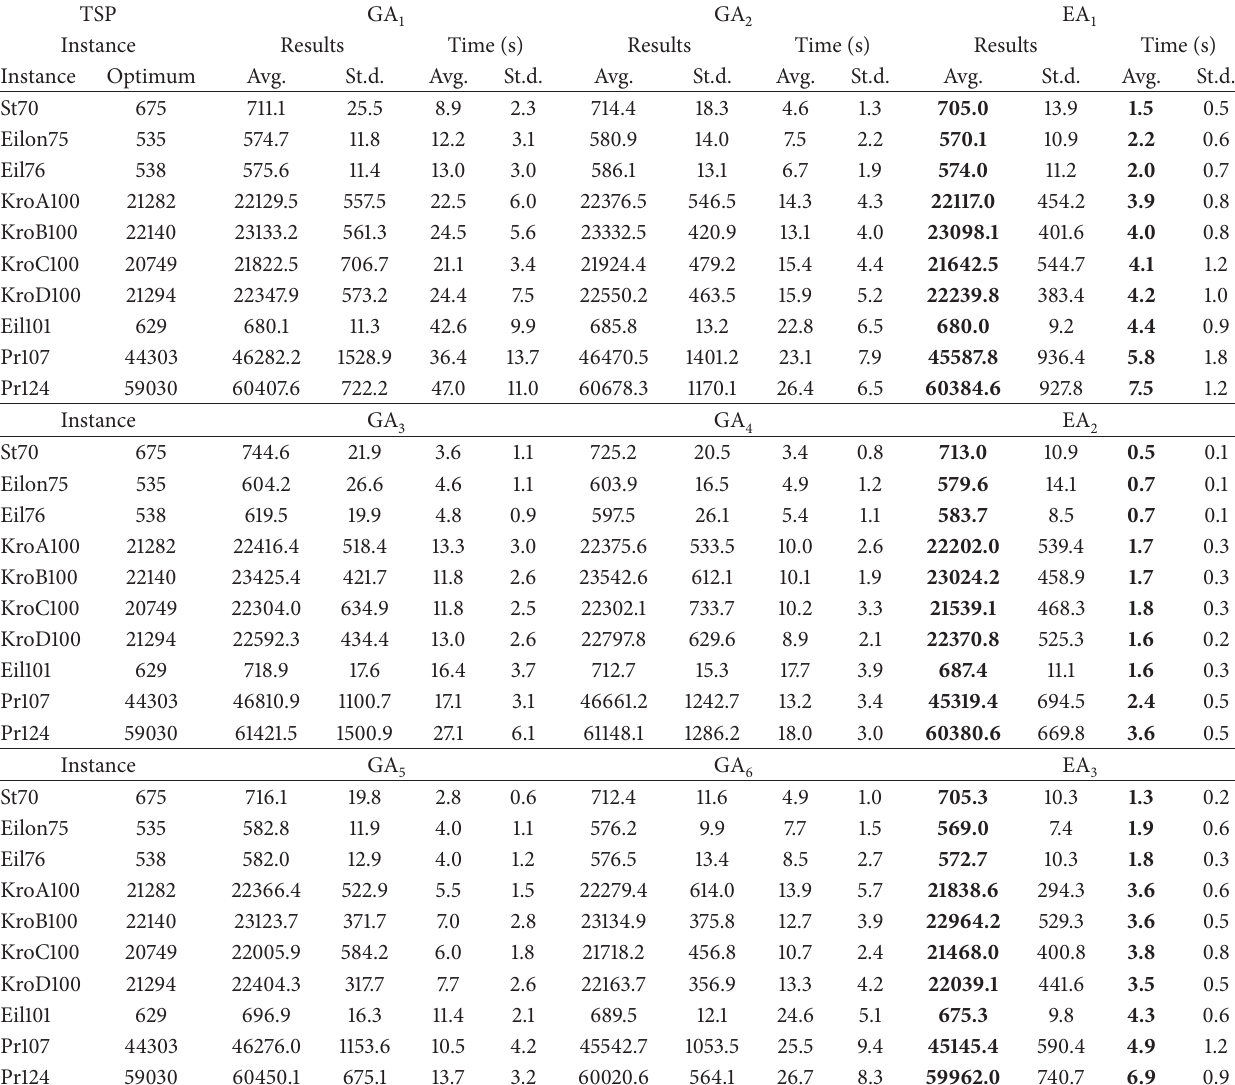
Table 2: Results and runtimes of the nine techniques applied to the TSP. For each instance, the results, average runtime, and their standard deviations are